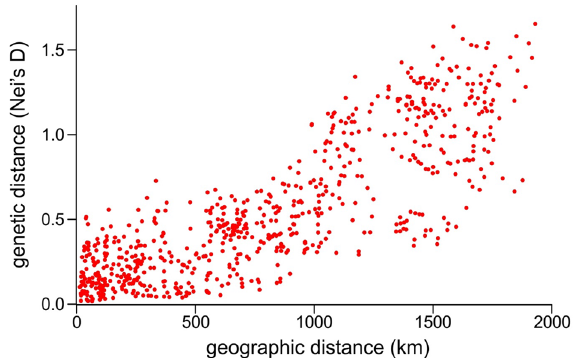
Figure 7. Test of isolation-by-distance at the population level (Mantel-test, p < 0.001).